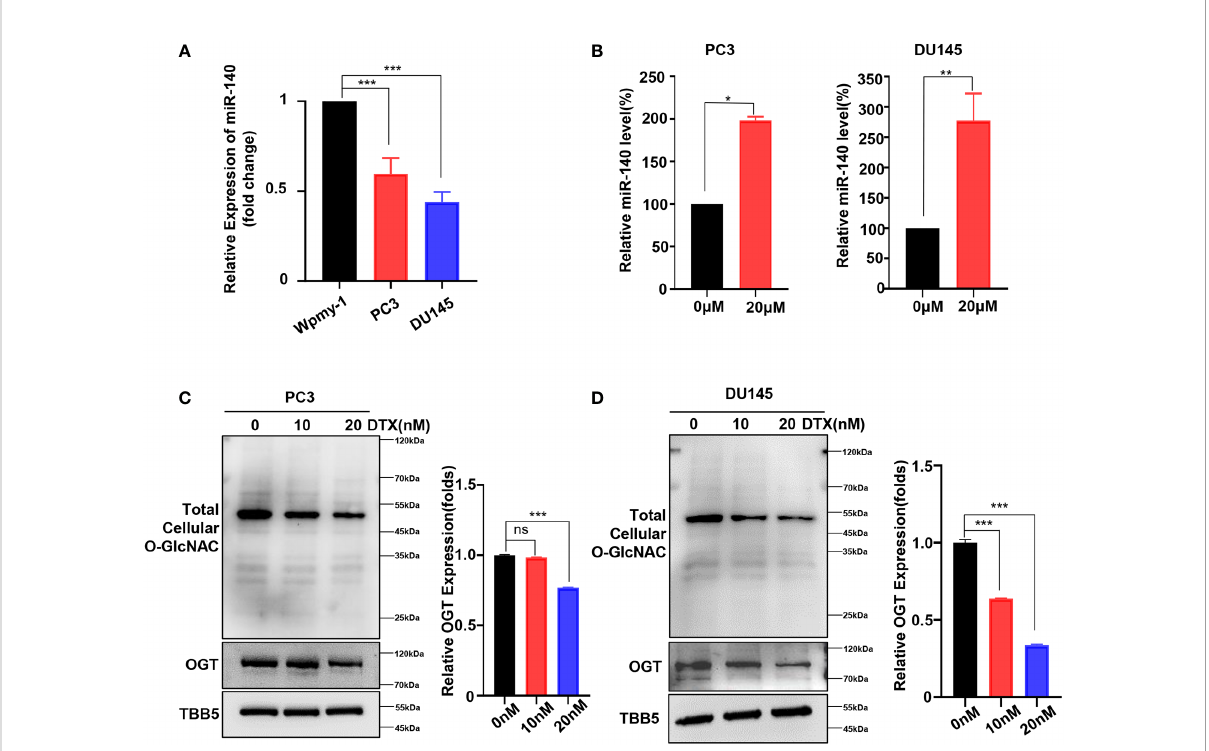
FIGURE 6 Docetaxel treatment decreases OGT expression and increases miR-140 expression. (A) RT-qPCR results showed that miR-140 expression levels were signi fi cantly downregulated in PC cell. Values are expressed as the mean±standard deviation. (B) MiR-140 expression levels were upregulated with the treatment of docetaxel. (C, D) OGT protein and O-GlcNAc levels were dramatically downregulated in PC3 and DU145 cells treated with different concentrations of docetaxel. *p < 0.05; **p < 0.01; ***p < 0.001 (Student ’ s t-test). ns, means no signi fi